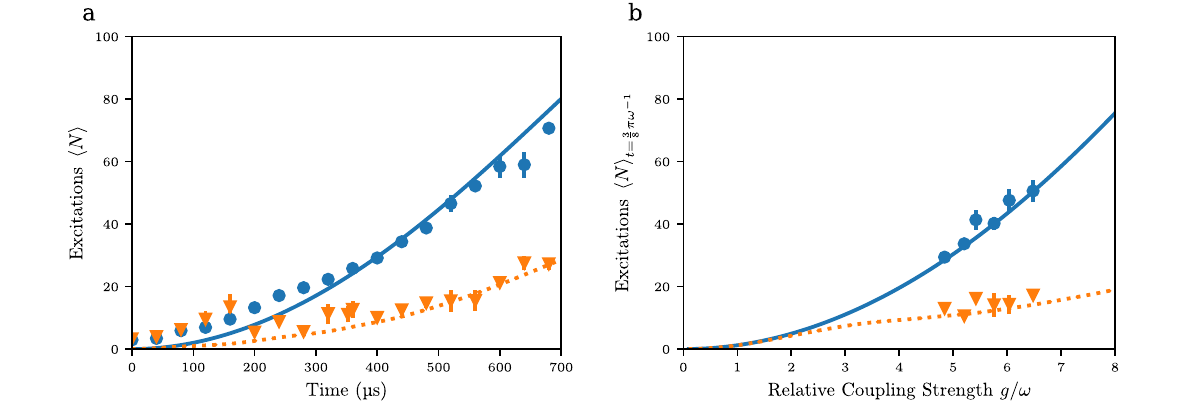
Fig. 2 | Creating system excitations. a Variation of the number of excitation state | − 2 _ k 〉 in the center of the harmonic trapping potential. b Variation of the number of excitations on the relative coupling strength g ω . Here a fi xed interaction =2275 23 ð Þ Hz quanta N h i in the potential versus interaction time for a coupling g 2 π andabosonicmode frequency ω 2 π =346 ð 7 Þ Hz,correspondingtoarelativecoupling time of 3 8 π ω was used, and blue dots and orange triangles correspond to qubit strength g ω =6 : 58 ð 7 Þ , i.e., far in the deep strong coupling regime. The used qubit spacings ω q =590 6 ð Þ Hzand5850(60)Hz,respectively.Thevisibleerrorbarsdenote 2 π =586 ð 6 Þ Hz (blue dots) and 5200(50)Hz (orange triangles). spacings were ω q the statistical 2 π The lines are theory. Atoms for this measurement are prepared in the momentum